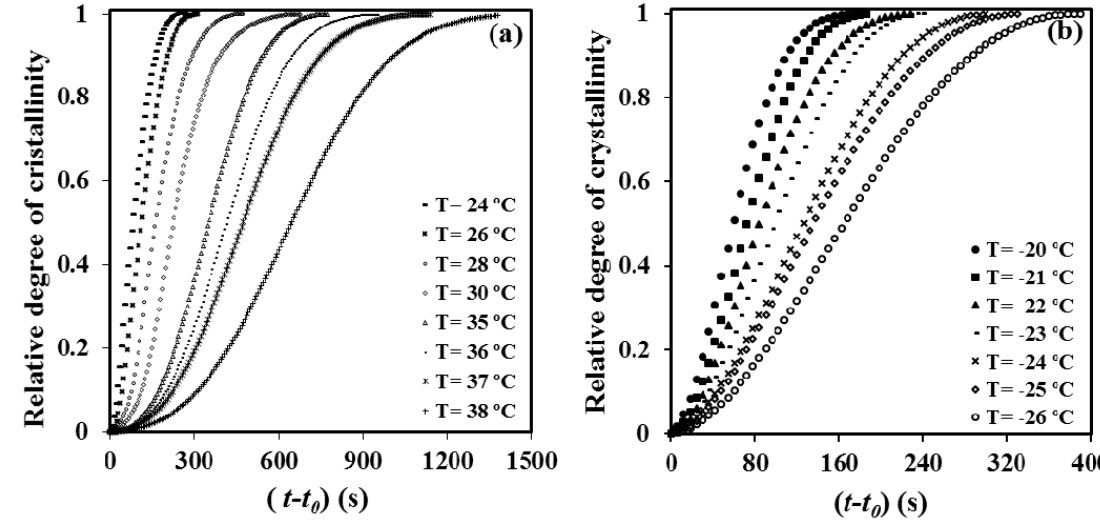
Figure 7. Evolution of the relative crystallinity over time for isothermal crystallizations of P4HB at the indicated temperatures. ( a ) Samples coming from the melt state; ( b ) Glassy sample obtained from a fast cooling from the melt. Table 1. Isothermal crystallization kinetic parameters deduced from calorimetric (DSC) experiments for poly(4-hydroxybutyrate (P4HB).